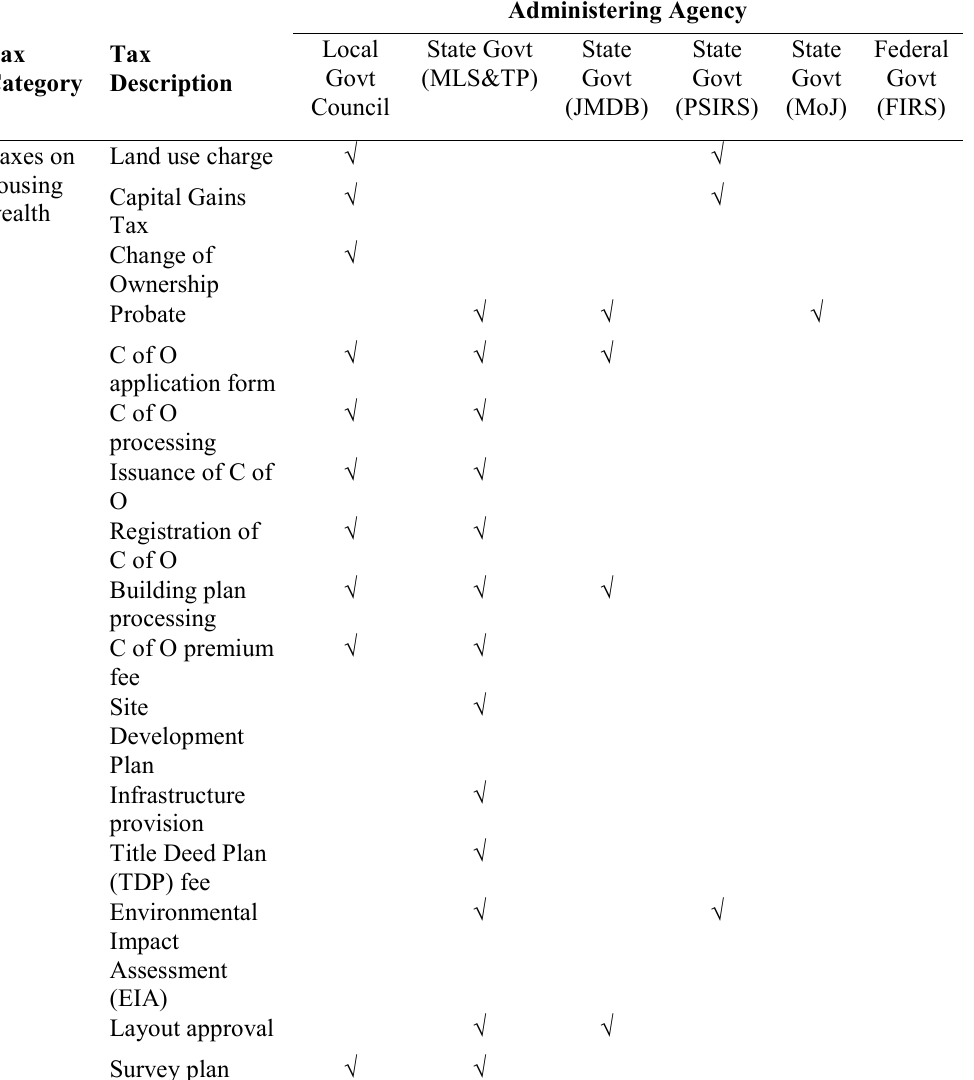
Table 2. Property Taxes and their